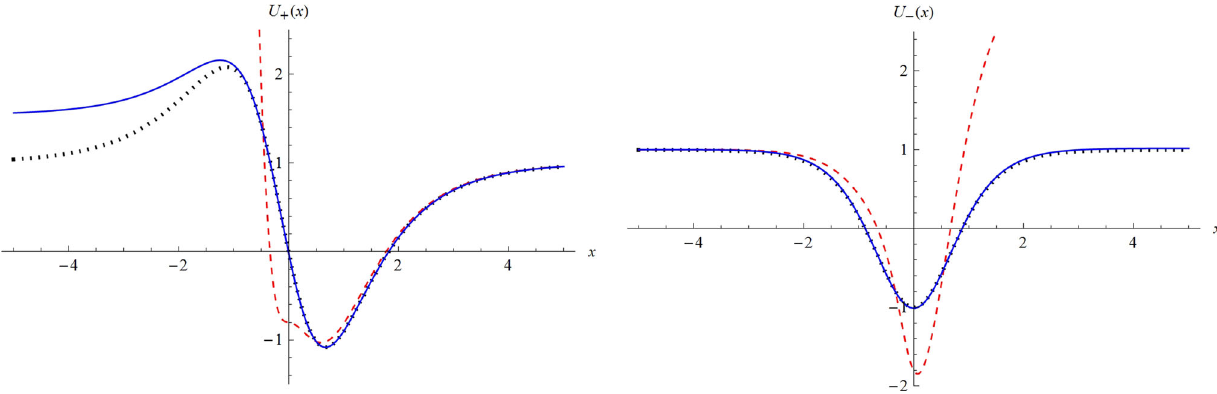
Fig. 6 Quantum-mechanical potentials U + (on the left) and U − (on the right) for a 2 = 0 and α = 1. For both, we have plotted the values b 3 = 0, b 3 = − 0 . 01, and b 3 = − 0 . 8, depicted with dotted, solid, and dashed lines, respectively